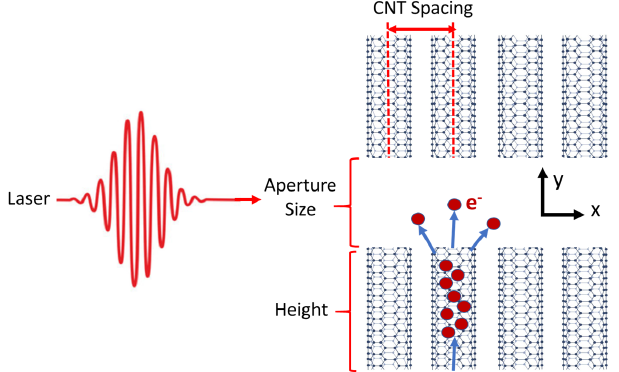
Figure 6. Visual diagram of the CNT-laser setup where a laser is injected perpendicularly to an array of